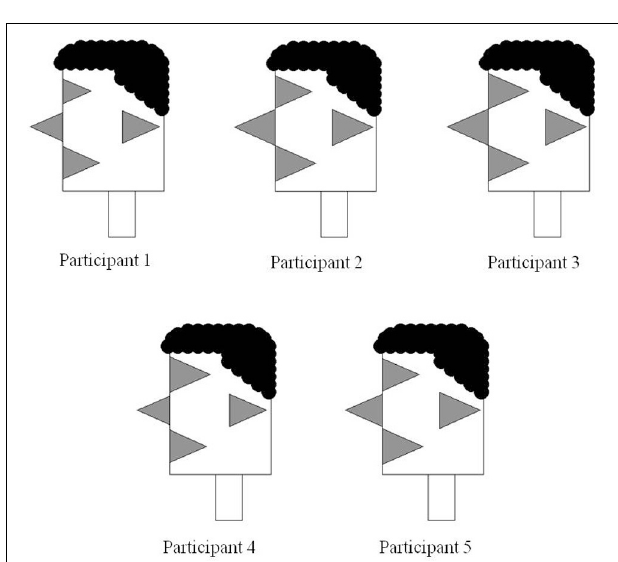
FIGURE 8 | Encasing the triangles from Figure 5 into facial profiles enables their perception as facial features. Recoding of bar graph into relative triangle sizes. This is the third and final step in the development of visual participant profiles.